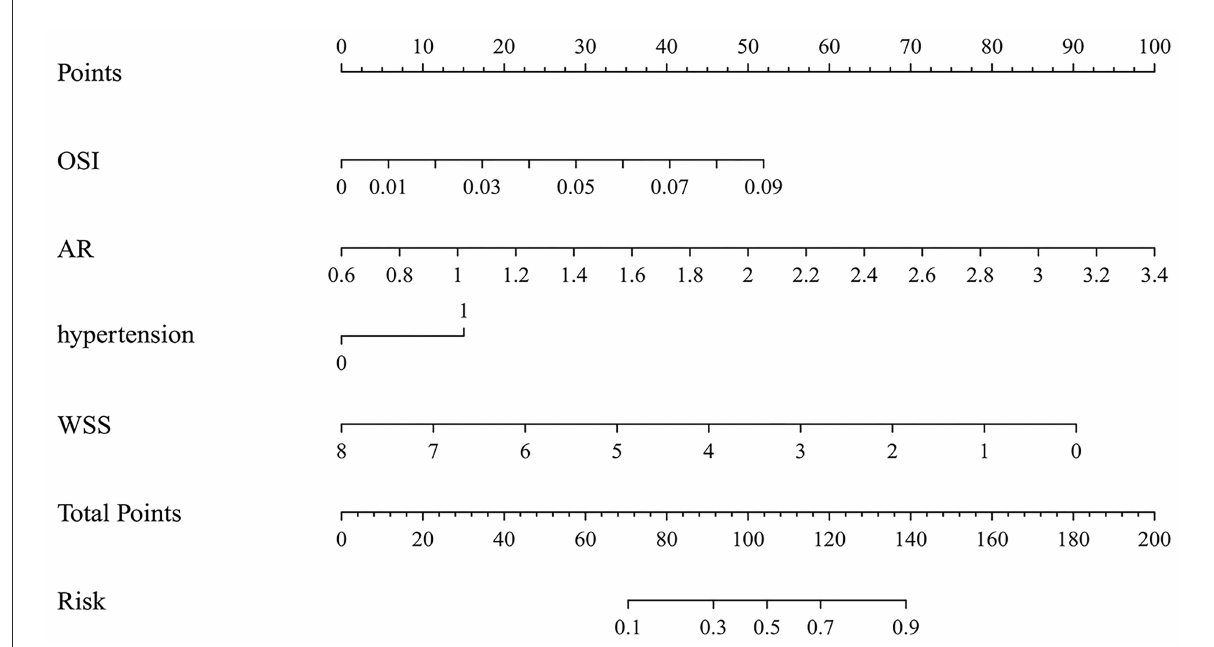
FIGURE2 The nomogram model predicts the rupture risk of PcomA aneurysms, based on OSI, AR, hypertension, and WSS. OSI, oscillatory shear index; AR, aspect ratio; WSS, wall shear stress.